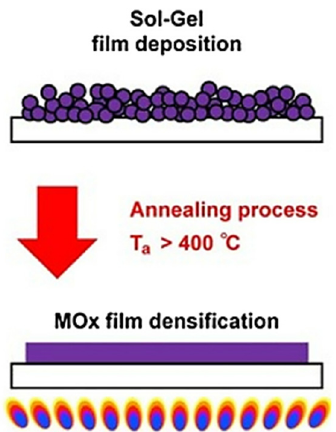
Figure 9. A schematic of densifying a sol–gel metal oxide film from as-spun xerogel via high-temperature thermal annealing [40]. Reprinted with permission from [40]; 2017 Elsevier.